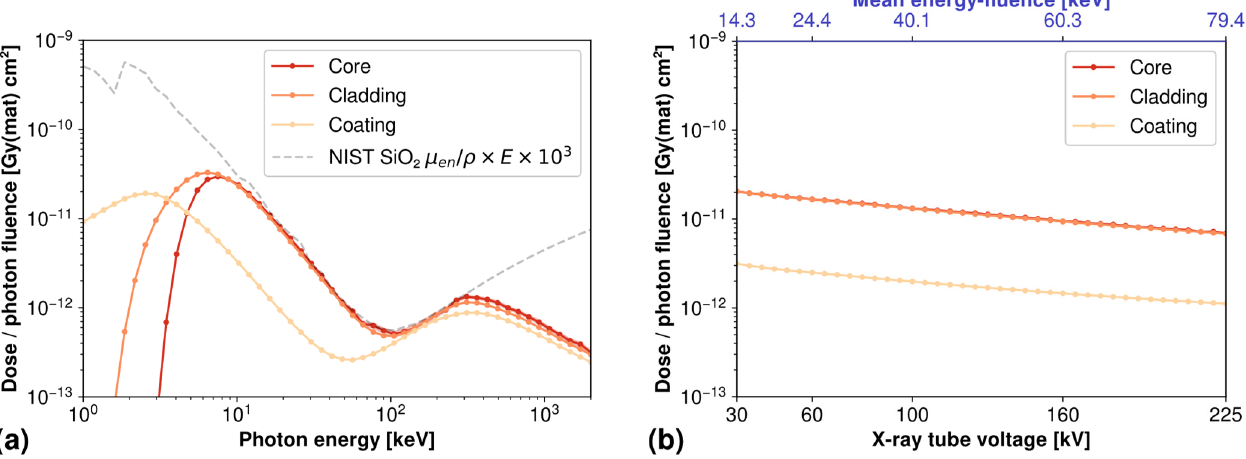
Figure 6. ( a ) Simulated dose/fluence of the OF for monoenergetic photons from 1 keV to 2 MeV. ( b ) Simulated dose/fluence of the OF for X-ray tube spectra at different operating